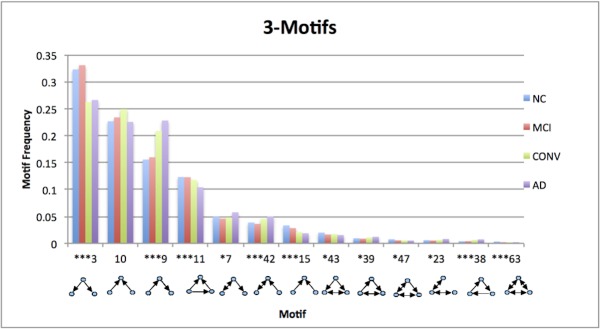
Motif frequencies for NC, MCI, CONV and AD.Significance refers to NC/AD comparisons.